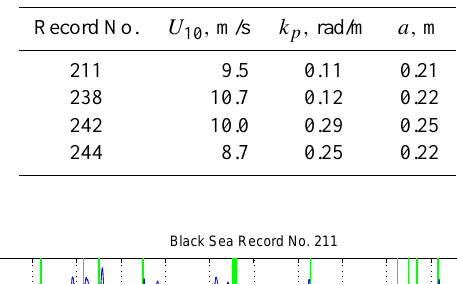
Table 1. Summary of the Black Sea data used; U 10 is the wind speed at 10m height, k p is the peak wave number, a is the standard deviation wave amplitude.